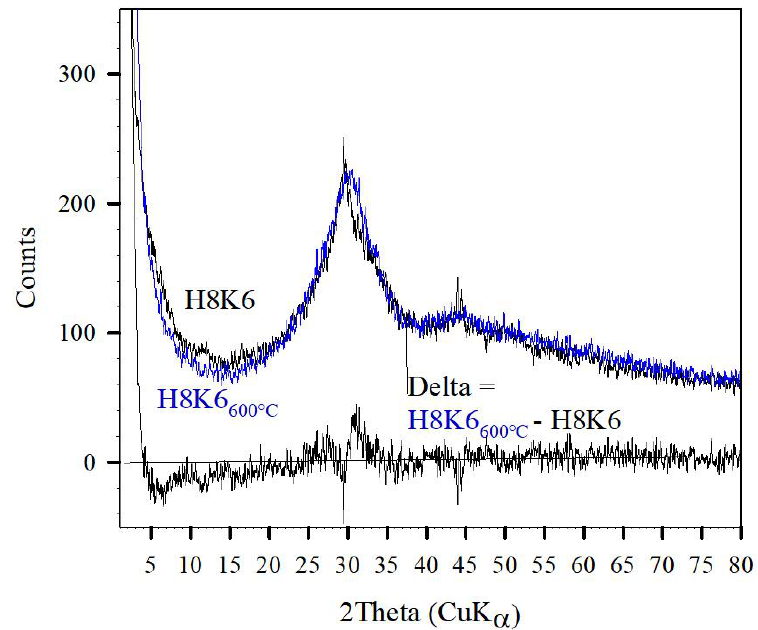
Figure 10. XRD diagramms of AAH sample before and after thermal treatment at 600 °C and the difference pattern as denoted.